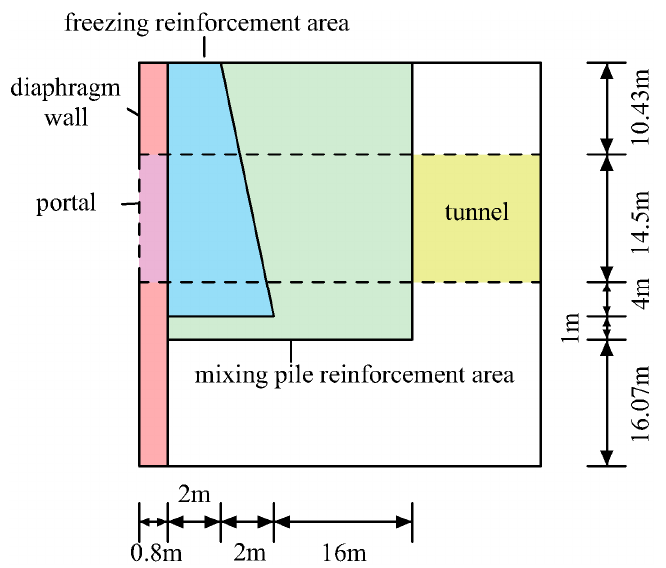
Figure 8. Optimized reinforcement scheme diagram of the Wuhu River Crossing end.